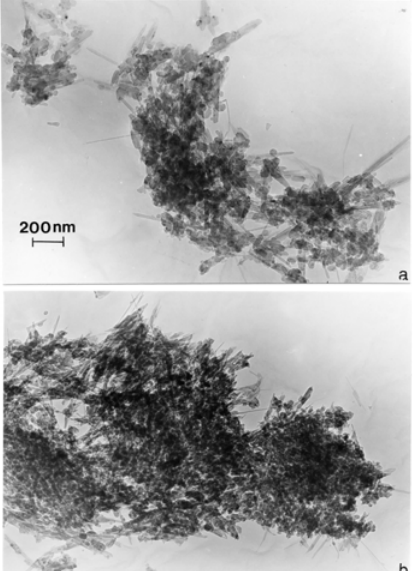
Figure 4: TEM bright-field images of MWCNT aggregates collected by thermal precipitation. (a) Variety of MWCNTs and multiconcentric fullerenic PM from propane kitchen range. (b) Dense aggregate of short MWCNTs and multiconcentric fullerenes from outdoor, industrial natural gas